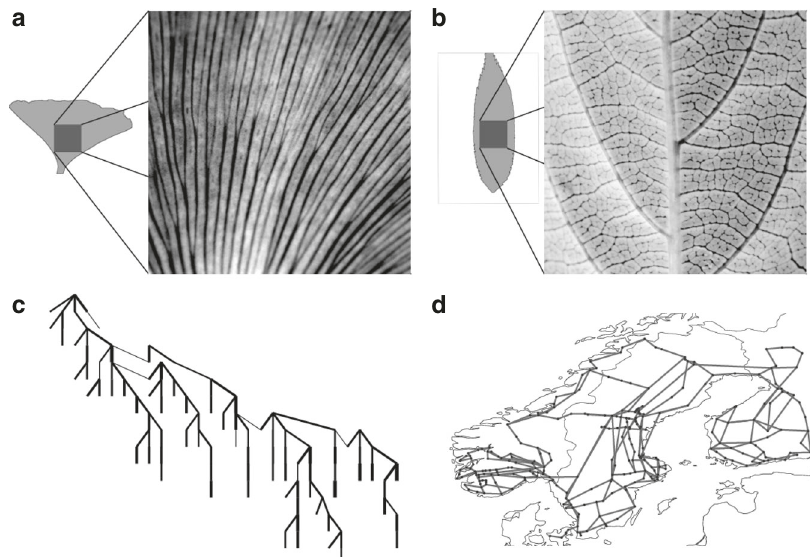
Fig. 1 Loopy and non-loopy real-world supply networks. a The leaves of Ginkgo biloba and c the distribution grid IEEE123 form loopless supply networks. b The venation network of Prunus serrulata and d the Scandinavian power grid on the transmission level form loopy supply networks. Leaf venation networks extracted from photographs, distribution grid taken from ref. 50 and transmission grid topology extracted from the open power system model PyPSA-Eur 49